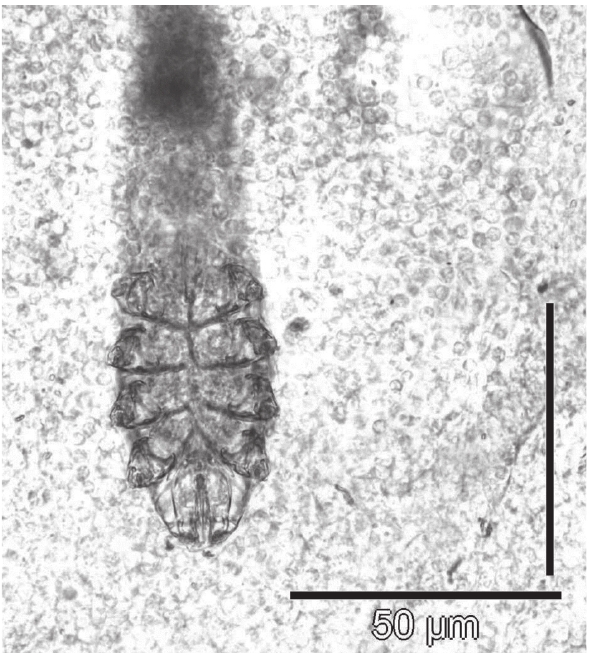
Fig. 1. – Demodex bovis is a worm-shaped, elongated mite (Acari: Prostigma), and that particular morphology makes its direct iden- tification easy (photonic microscope ×200, after dilution in Phos- phate Buffer Saline). Many parasites are found in the comedones embedded in the hair follicles.